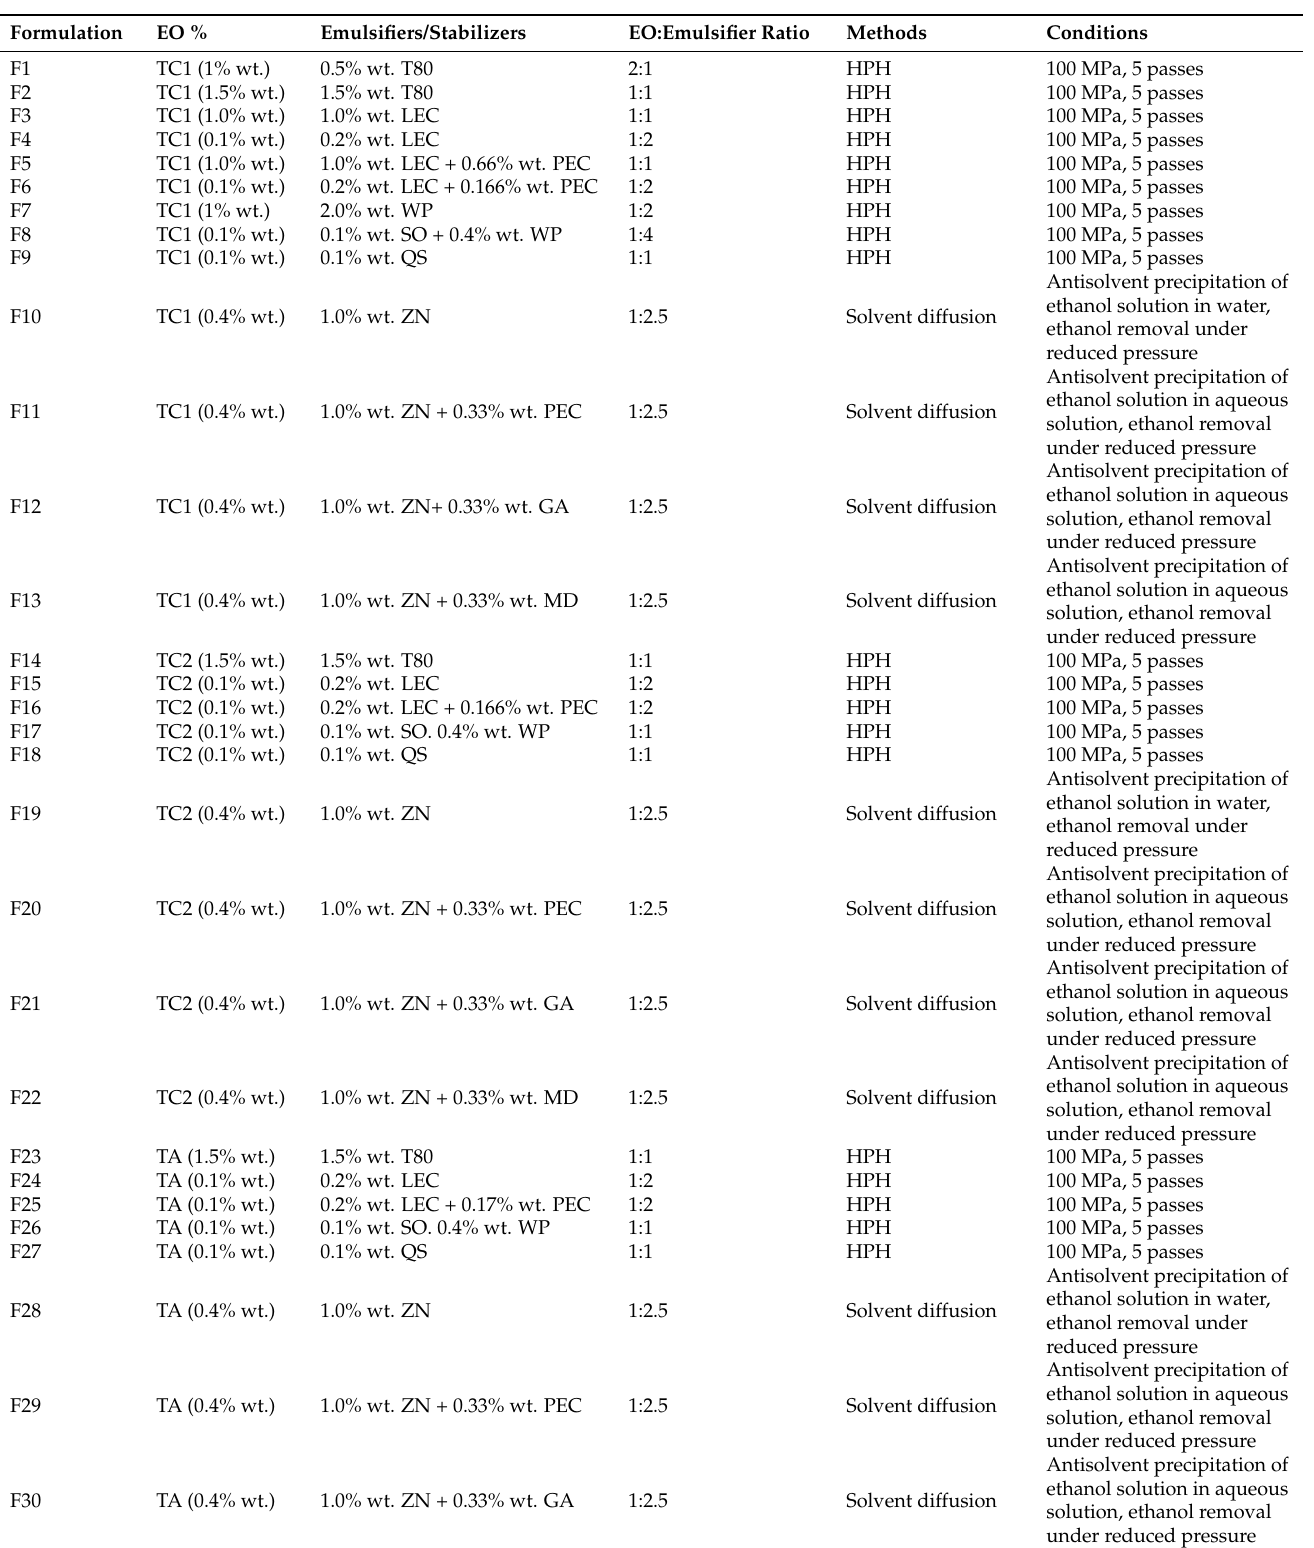
Table 1. Formulations of delivery systems of essential oils of TC1 ( Thymus capitatus, harvested in July), TC2 ( Thymus capitatus, harvested in April), and TA ( Thymus algeriensis, harvested in April).Abbreviations: HPH (High-Pressure Homogenization), T80 (Tween 80), LEC (Lecithin), PEC (Pectin), WP (Whey proteins), SO (Sunflower oil), QS (Quillaja saponin), ZN (Zein), GA (Gum arabic), MD